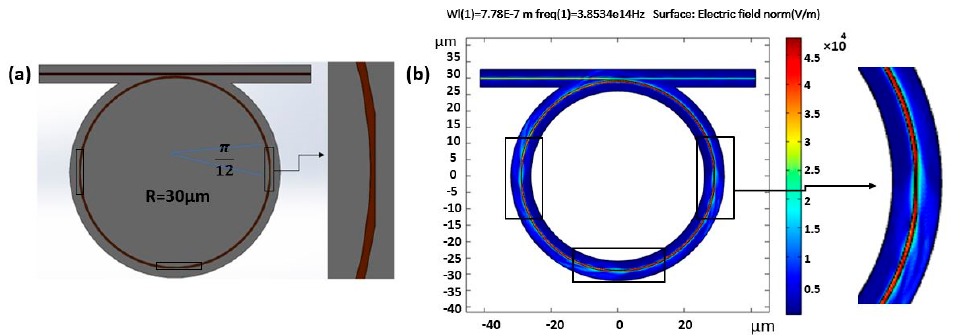
Figure 1. ( a ) Partially tapered ring with a 30 μ m radius and ( b ) 3 parts tapered at 0, π , 3 π /2; tapered part angle is ( π /12).